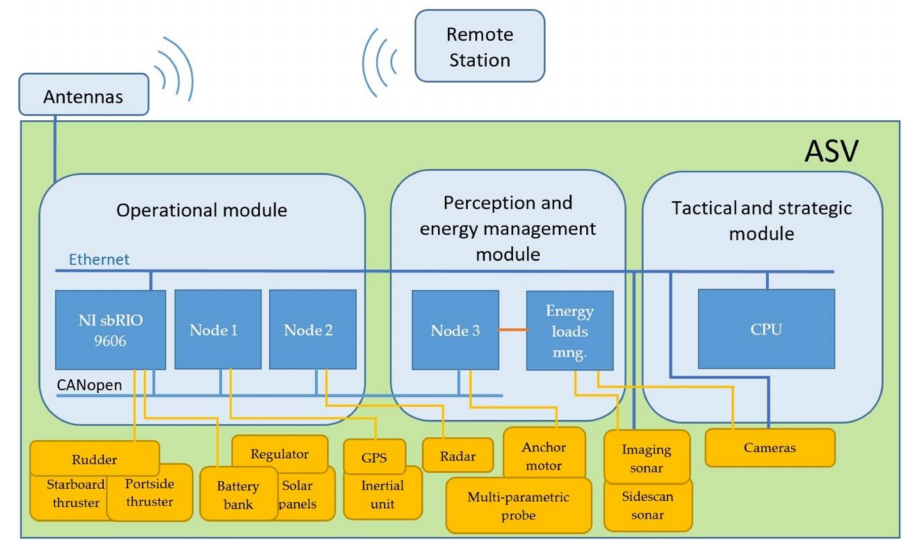
Figure 3. BUSCAMOS-RobObs hardware components and communication